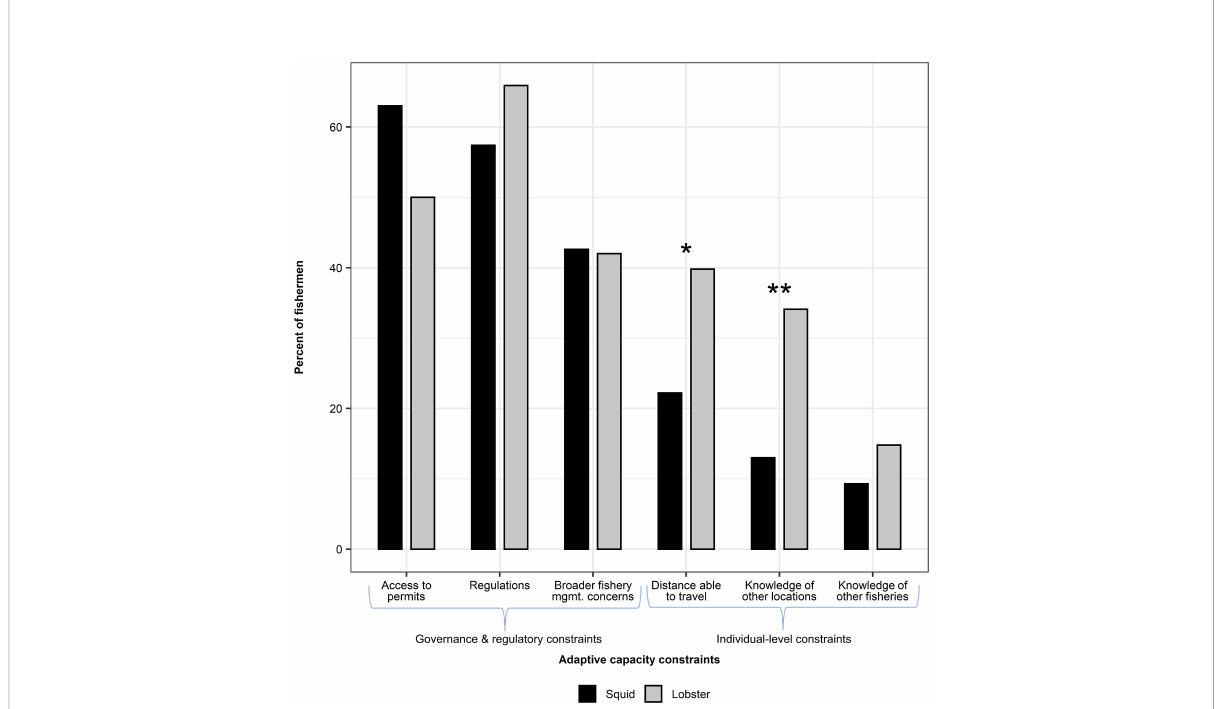
FIGURE 3 Percent of market squid fi shermen (n = 54) and spiny lobster fi shermen (n = 88) who stated that each factor constrained their capacity to adapt to future change. * Statistically signi fi cant difference between the proportion of fi shermen in each fi shery (z = 2.16, p = 0.015). ** Statistically signi fi cant difference between the proportion of fi shermen in each fi shery (z = 2.78, p =